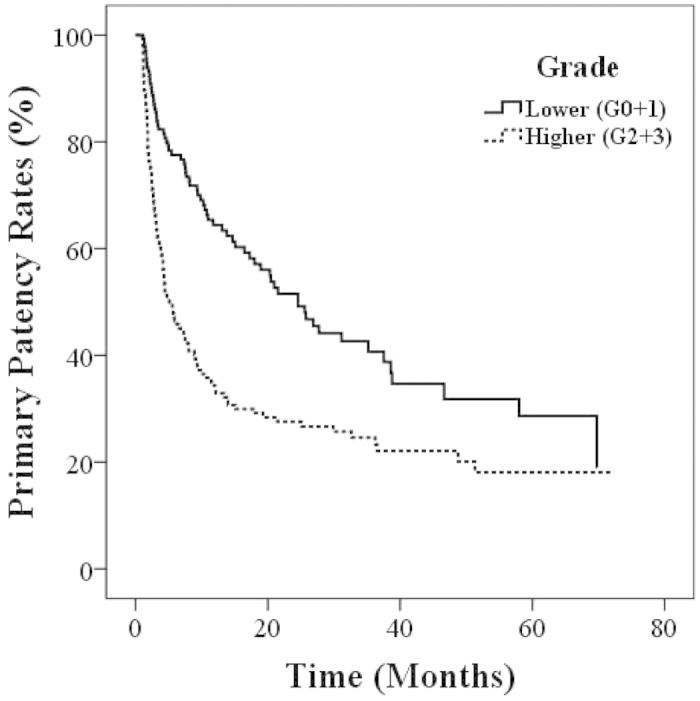
Kaplan–Meier curves for primary AVF patency in patients with lower grade (grades 0 + 1) and higher grade (grades 2 + 3) aortic arch calcifications.Log-rank p < 0.001.